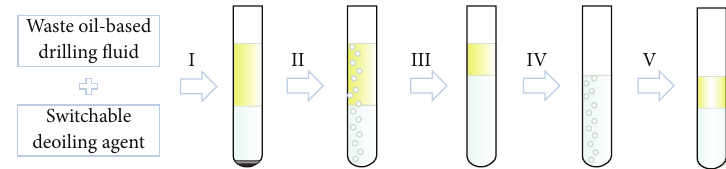
Figure 5: The process of oil removal and SDA